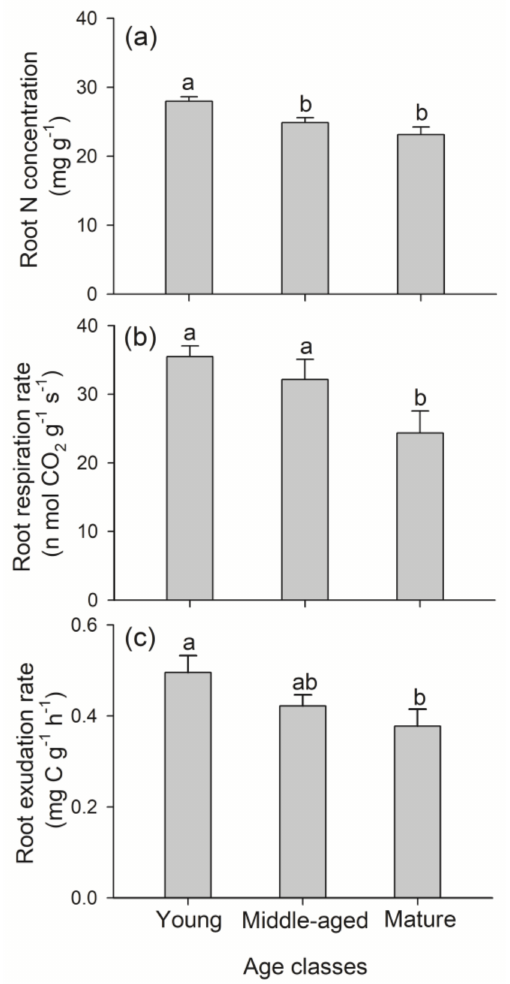
Figure 2. Root nitrogen concentration (RN, ( a )), root respiration rate (RR, ( b )), and root exudation rate (RE, ( c )) in Fraxinus mandshurica at different tree ages. Mean is shown as a bar, and SE as a whisker ( n = 5). Different lower-case letters indicate significant differences ( p < 0.05) among age classes in each